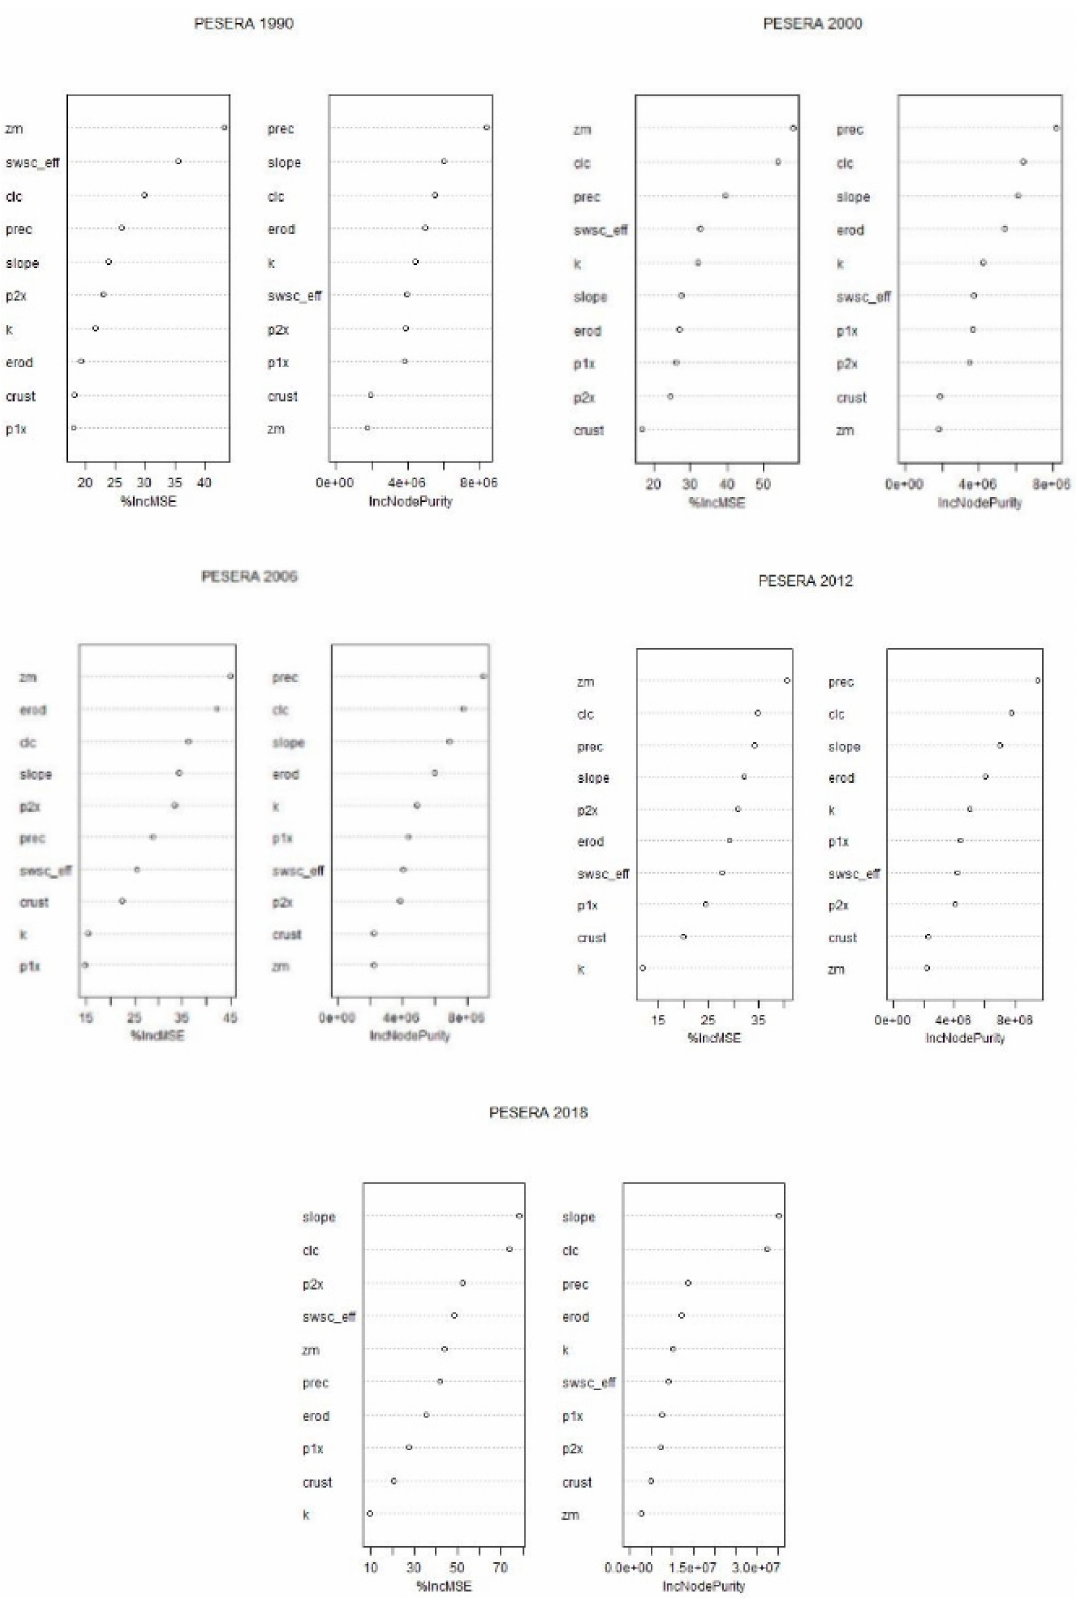
Figure A3. Variable importance based on Random Forest regression for PESERA model for all modeled